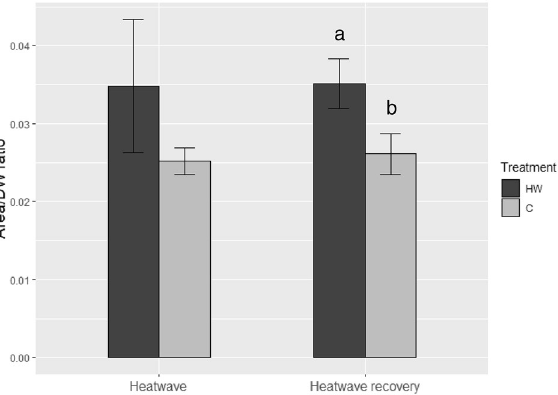
Figure 4. Area vs dry weight (DW) ratio of C. nodosa ’s leaf tissues. Leaf tissues from shoots cultivated in heatwave (HW) and control (C) conditions were sampled both during the heatwave and during heatwave recovery. Values are means ± SD ( n = 5 ). Different letters indicate significant differences ( p <